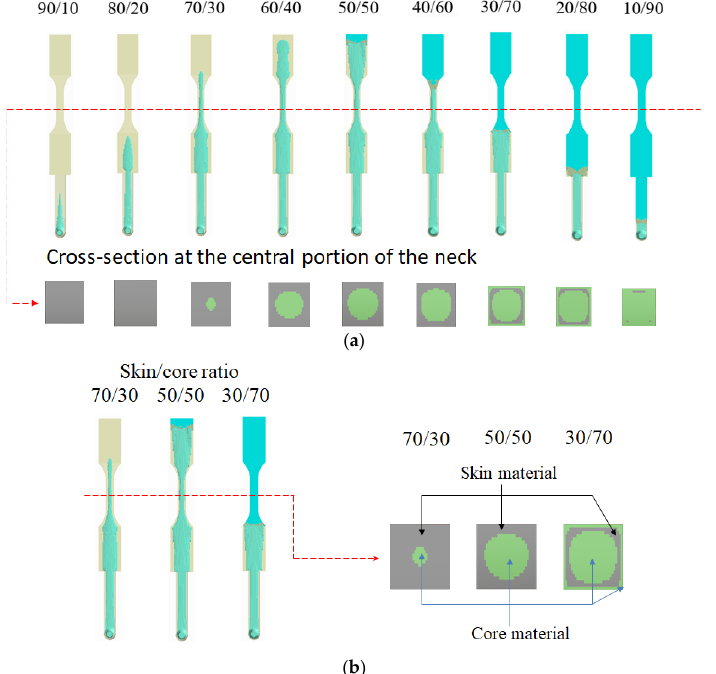
Figure 5. The flow patterns of the core material penetration and their cross section at central portion: ( a ) skin to core ratio from 90/10 to 10/90 and ( b ) the comparison of the flow pattern via the cross section for skin to core ratio of 70/30, 50/50, and 30/70.